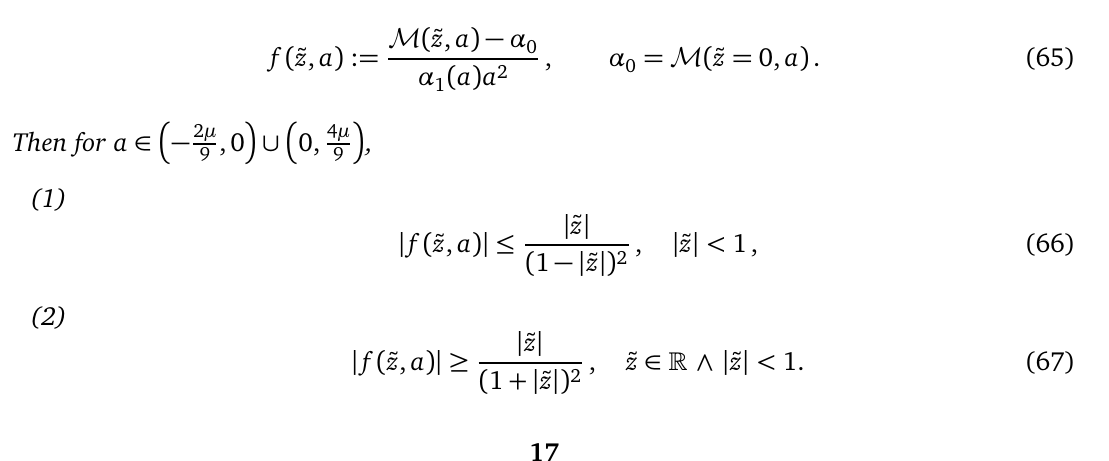
Figure 4: Constraints on Wilson coefficients using (63). Given W figure shows that bound on the W must lie inside the triangle. Black line is the exact answer. Different values of a are indicated with different